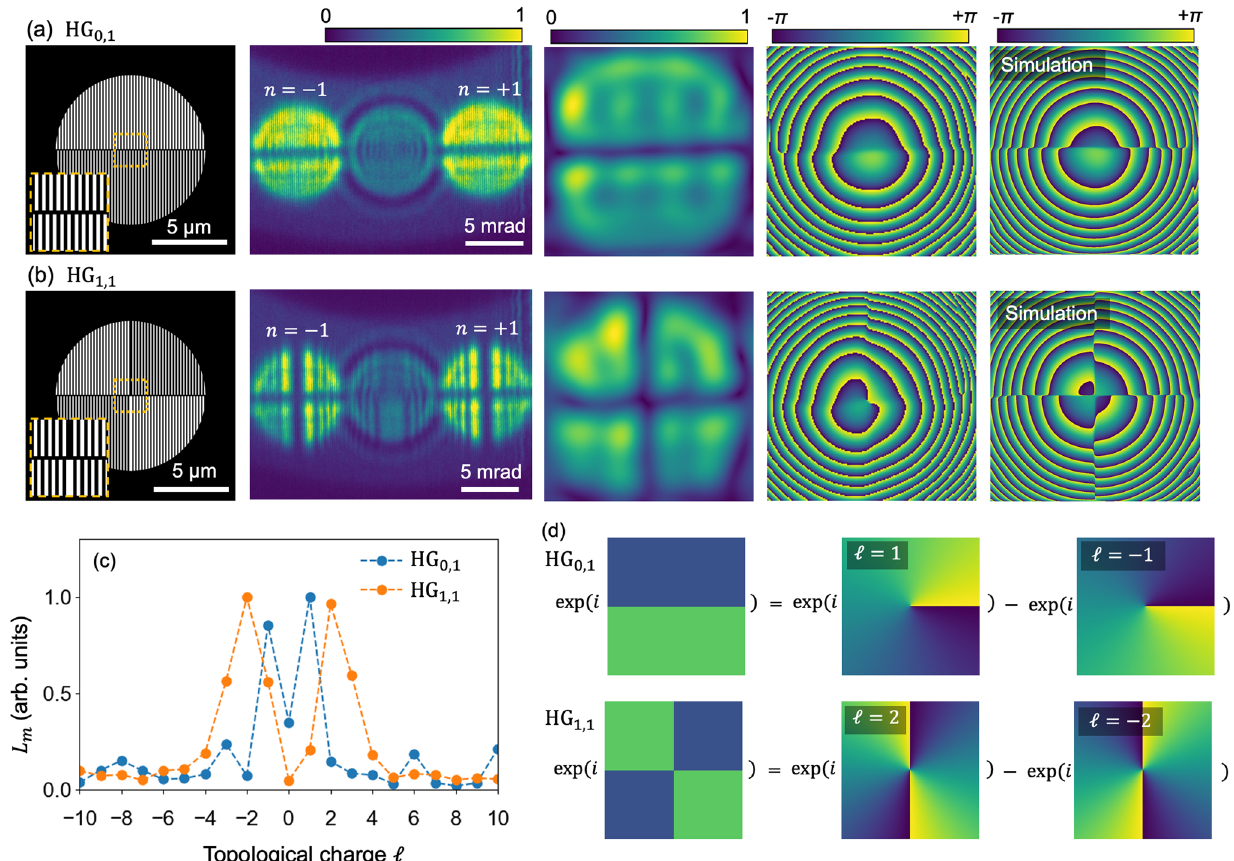
Figure 3. ( a , b ) Inline holography for Hermite–Gauss states HG 0,1 and HG 1,1 . Schematic of the gratings for producing HG 0,1 and HG 1,1 states (first column). Insets show enlarged views around the center of the gratings. holographic images for the diffraction waves from these gratings (second column), A (ρ fn , φ fn ) (third column) and the phase distribution (fourth column) for the n = + 1 diffraction, and the simulated phase distribution (fifth column). ( c ) TC spectra for the HG 0,1 and HG 1,1 states; figure ( d ) shows that these states can be decomposed into two LG